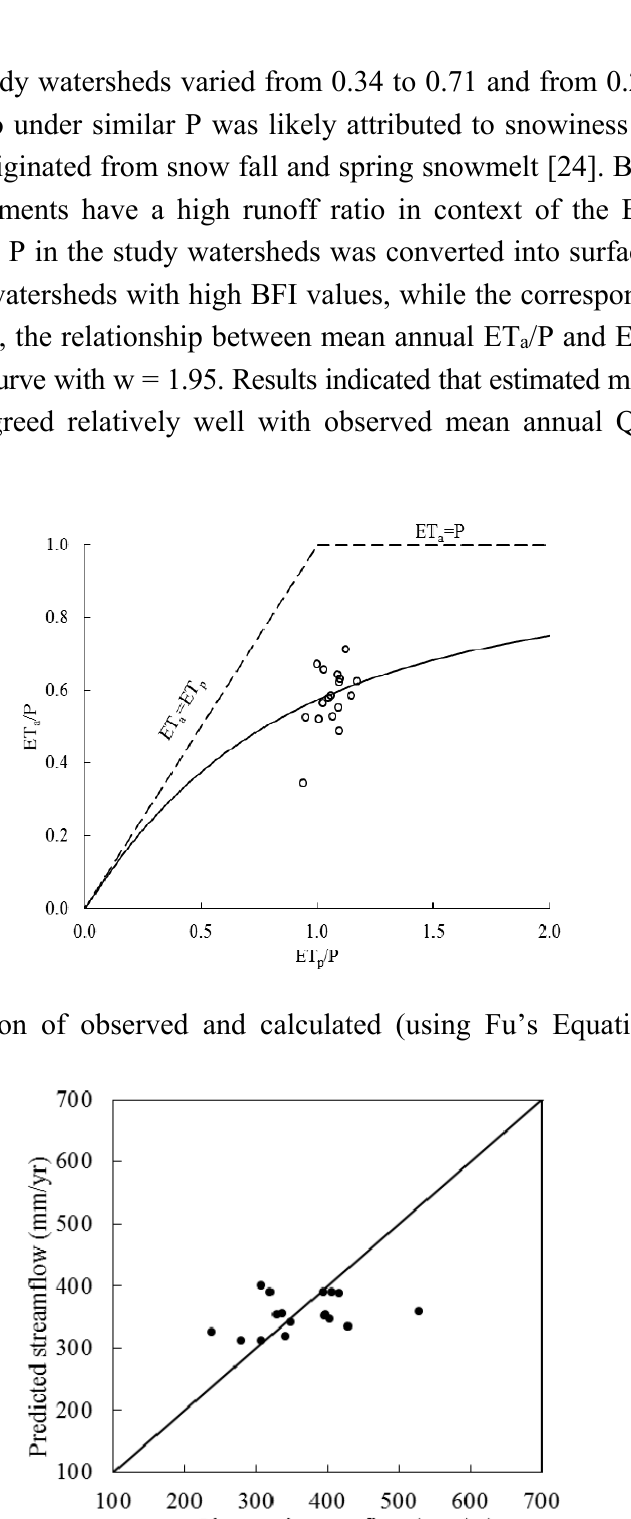
Figure 2. Predicted vs. observed mean annual streamflow in the study